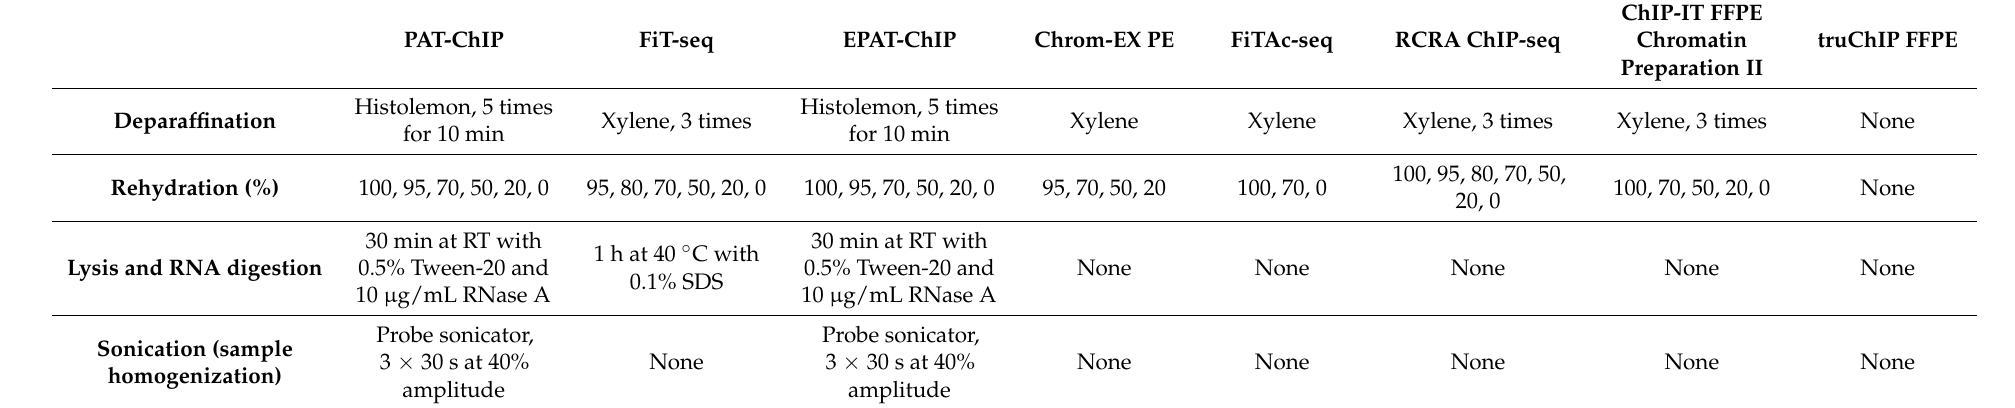
Table 2. Summary of the procedural steps used by the different FFPE-ChIP techniques and kits for tissue processing before chromatin isolation.